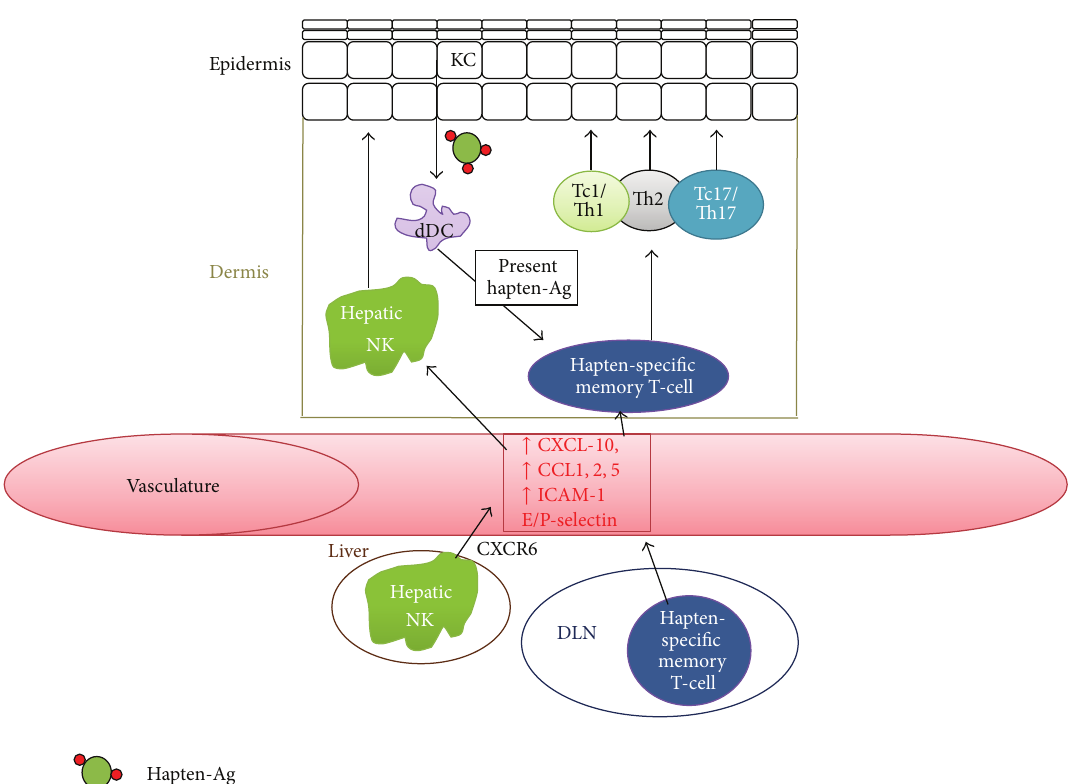
Figure 3: The likely pathway of the “late elicitation” phase of contact hypersensitivity. The red type indicates the “early” elicitation phase and the black arrows indicate the “late” elicitation phase. Hapten-specific memory T-cells will traffic to the hapten challenge site, where they will enter the dermis and divide into multiple different cells subsets. This will be initiated by dermal APCs presenting antigen as well as cytokine release from multiple different cell subsets. The multiple subsets will play different roles in the CHS reaction at the site. Lastly, CXCR6+ hepatic NK cells will traffic to the hapten challenge site and elicit